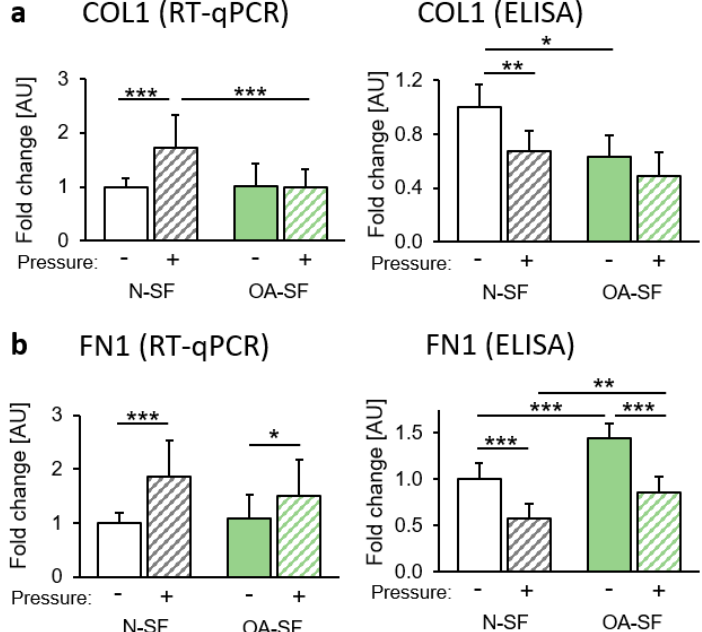
Figure 2. Impact of static compressive force application on the extracellular matrix. Gene expression and protein secretion of ( a ) COL1 and ( b ) FN1 of N-SF and OA-SF after 48 h with or without static compressive force application. AU: arbitrary units; RT-qPCR: n = 9; ELISA: n = 6. * p ≤ 0.05, ** p ≤ 0.01, *** p ≤ 0.001. Statistics: Welch-corrected ANOVA with Games-Howell post-hoc-tests.